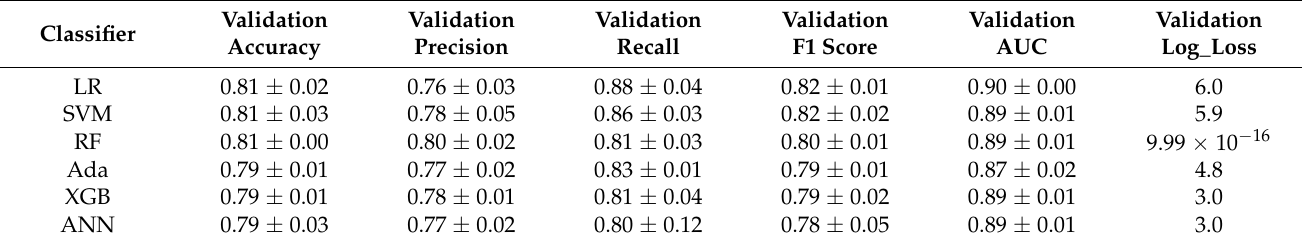
Table 8. Model performance metrics without hyper-parameter tuning during the validation phase (using three-fold cross-validation). The mean ± standard deviation values are provided.